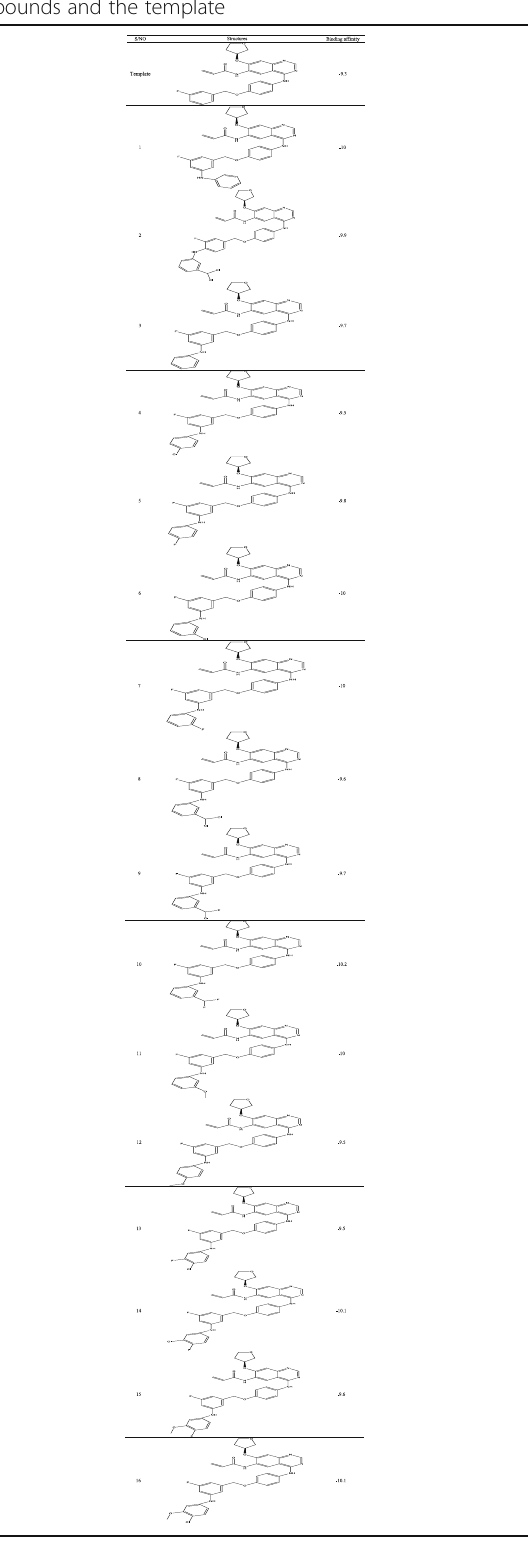
Table 4 The structure and binding affinities of newly designed compounds and the